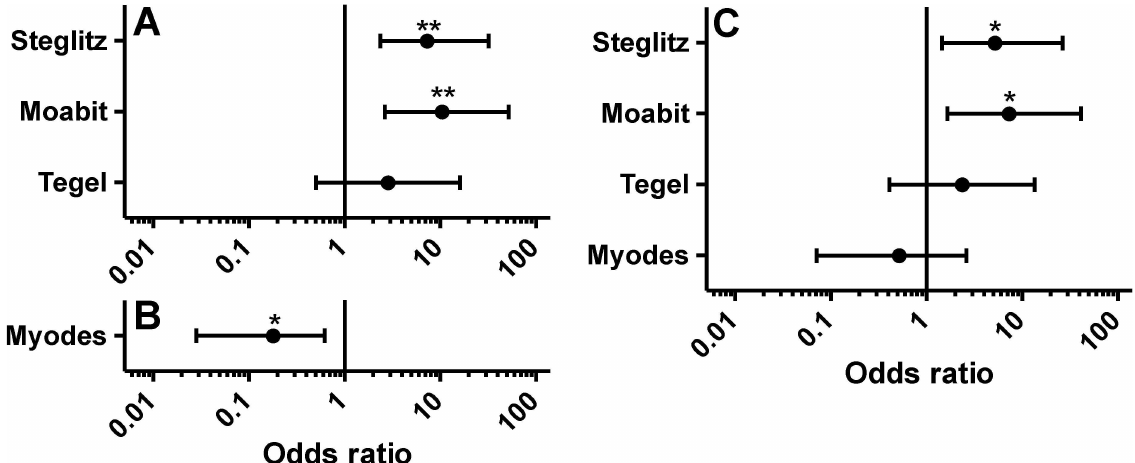
Fig 2. Odds ratios with 95% confidence intervals for variables determining the risk for detection of antibodies against Toxocara canis . Logistic regression was conductedusing the variablesstudy location(A), rodent genus(B) and a combination of both (C). Referencecategories were Apodemus for genusand Gatow for study location. The odds ratios for the genus Microtus were 1.1 × 10 − 7 in both models in (B) and (C) but are not presented since antibodiesagainst T . canis were not found in any sample from this genusand the very wide 95% confidenceintervals. * , p < 0.05; ** , p < 0.01.